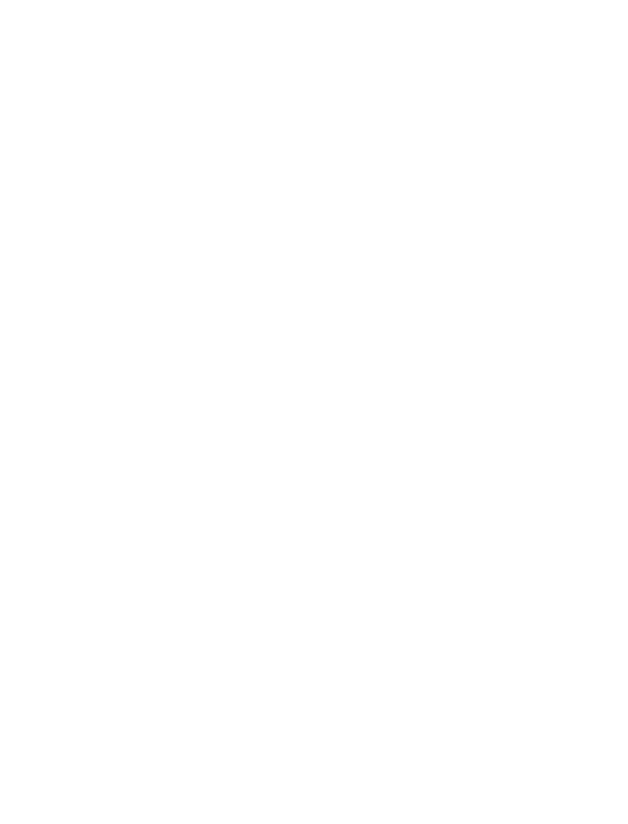
Goal 15: no high-fat